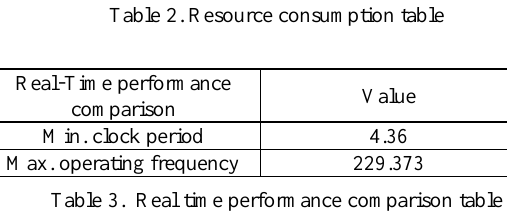
Figure 8. Elimination results of splicing